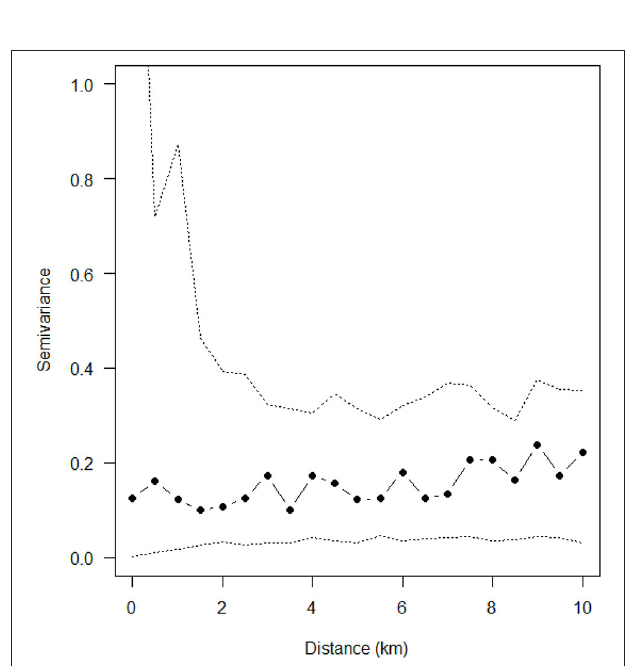
FIGURE 4 | Empirical variogram fitted to the posterior mean of the standardized residuals from reduced Poisson point process model explaining sarcocystosis-positive farm density. Dashed lines show the pointwise 95% posterior intervals constructed from 999 simulated realizations of the fitted spatial